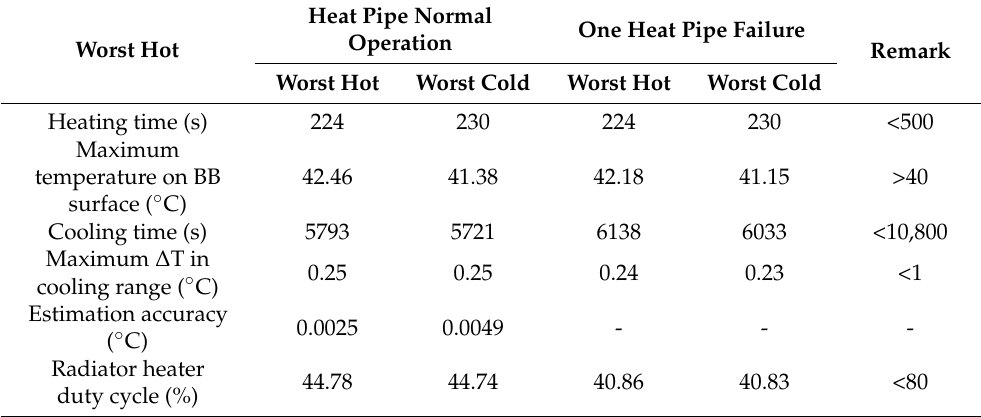
Table 6. Summary of thermal analysis results.